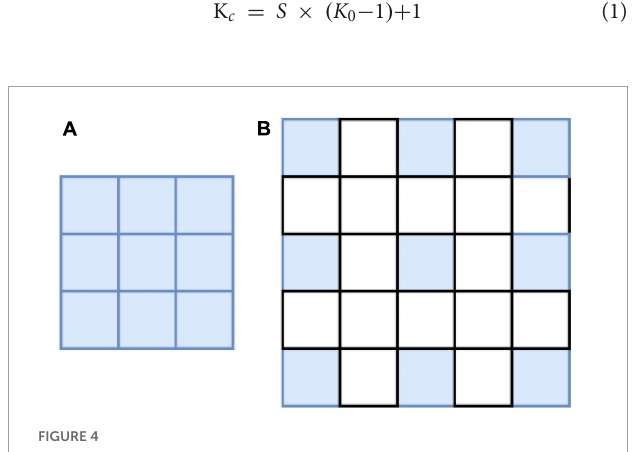
FIGURE4 Convolutional kernel schematic: (A) Common convolution (B) atrous